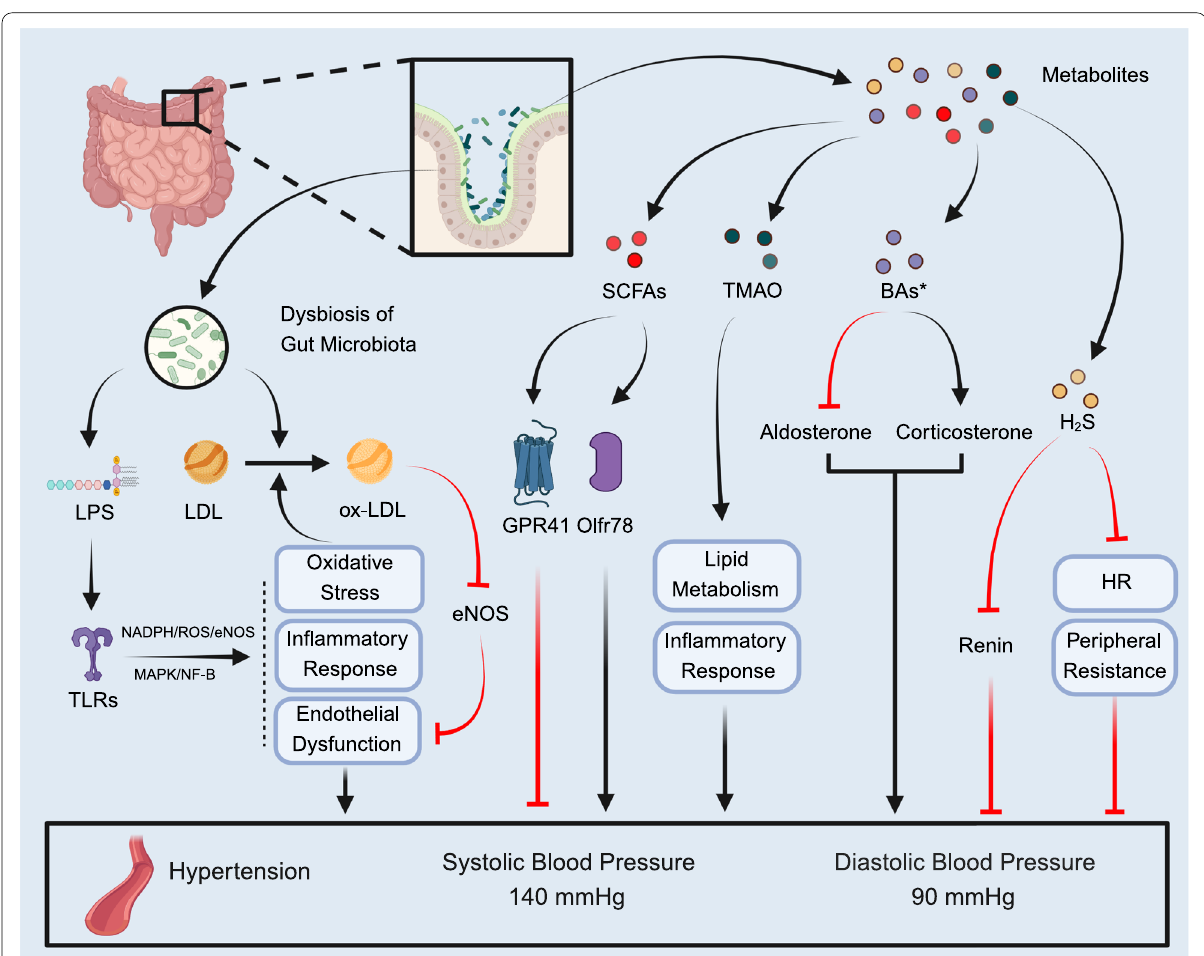
Fig. 4 The mechanism of gut microbiota increasing the risk of hypertension (created with BioRender.com). Hypertension is diagnosed in adults with systolic blood pressure 140 mmHg or diastolic blood pressure 90 mmHg. The dysbiosis and metabolites of gut microbiota can influence ≥ ≥ the course of hypertension. Abbreviations: SCFAs: short-chain fatty acids; TMAO: trimethylamine N-oxide; BAs: bile acids; LPS: lipopolysaccharide; TLRs: Toll like receptors; GPR41: G protein-coupled receptor 41; Olfr78: olfactory receptors 78; HR: heart rate; LDL: low density lipoprotein; ox-LDL: oxidized low-density lipoprotein; eNOS: endothelial nitric oxide synthase. *The regulatory effect of BAs on blood pressure is still controversial,